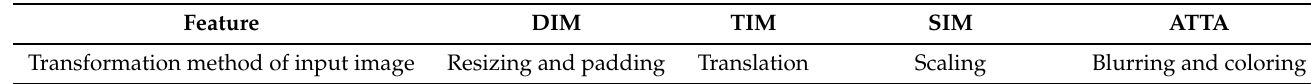
Table 2. The difference between attacks with input